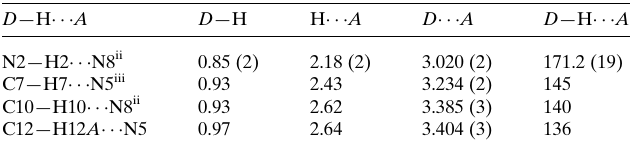
Table 2 Hydrogen-bond geometry (A˚ , (cid:4) ).